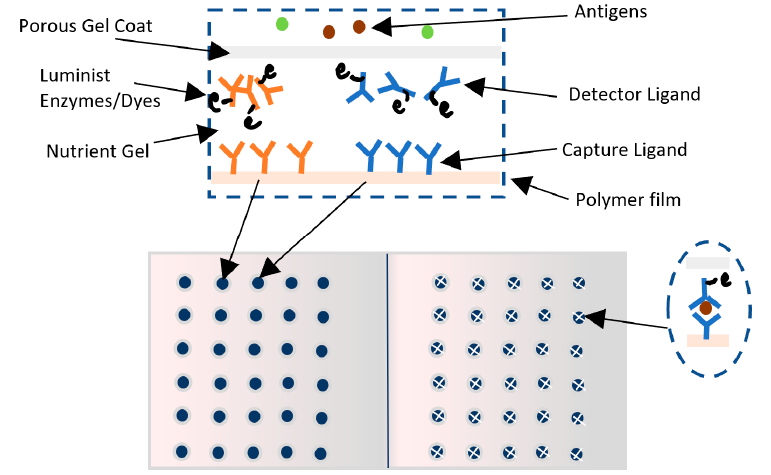
Figure 10. Toxin Guard TM biosensor.